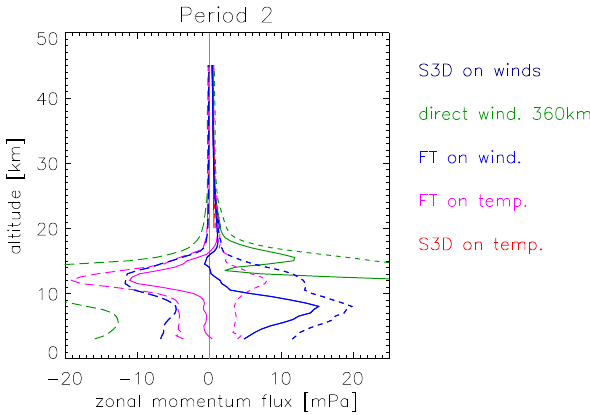
Fig. 1. Comparison of zonal momentum flux for period 2. Long-dashed lines indicate negative, dashed lines positive and solid lines net momentum fluxes. Below the tropopause momentum flux values are approx. a factor 20 larger than in the stratosphere and momentum flux values deduced from winds and temperatures are in discrepancy.